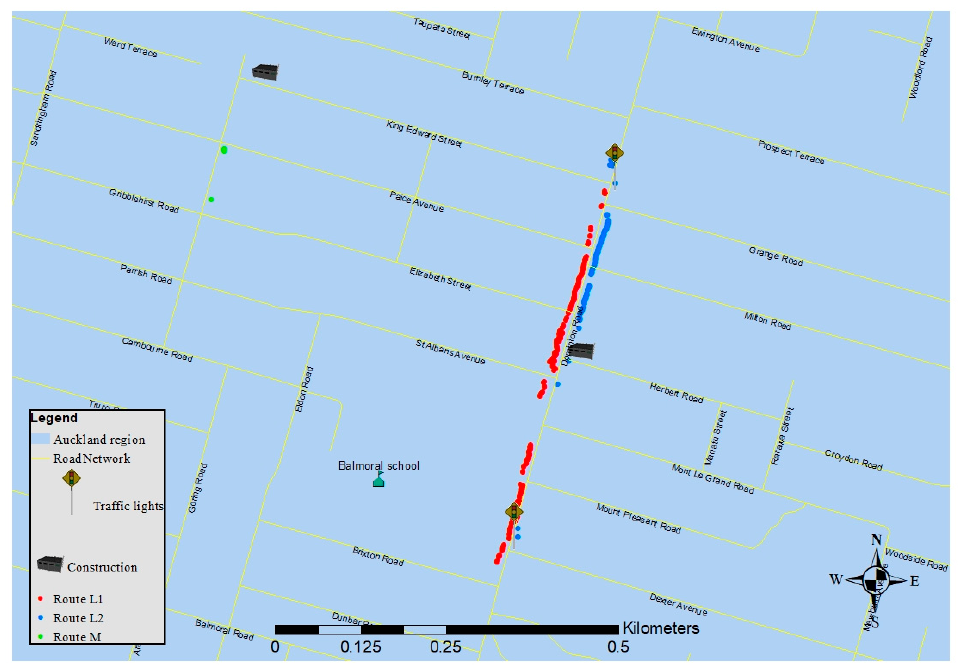
Figure 8. Map of the elevated exposures locations: points are well distributed for route L1. Only seven elevated exposure were observed in Route M. Most of the elevated exposures in route L2 appeared in the first segments of the route.